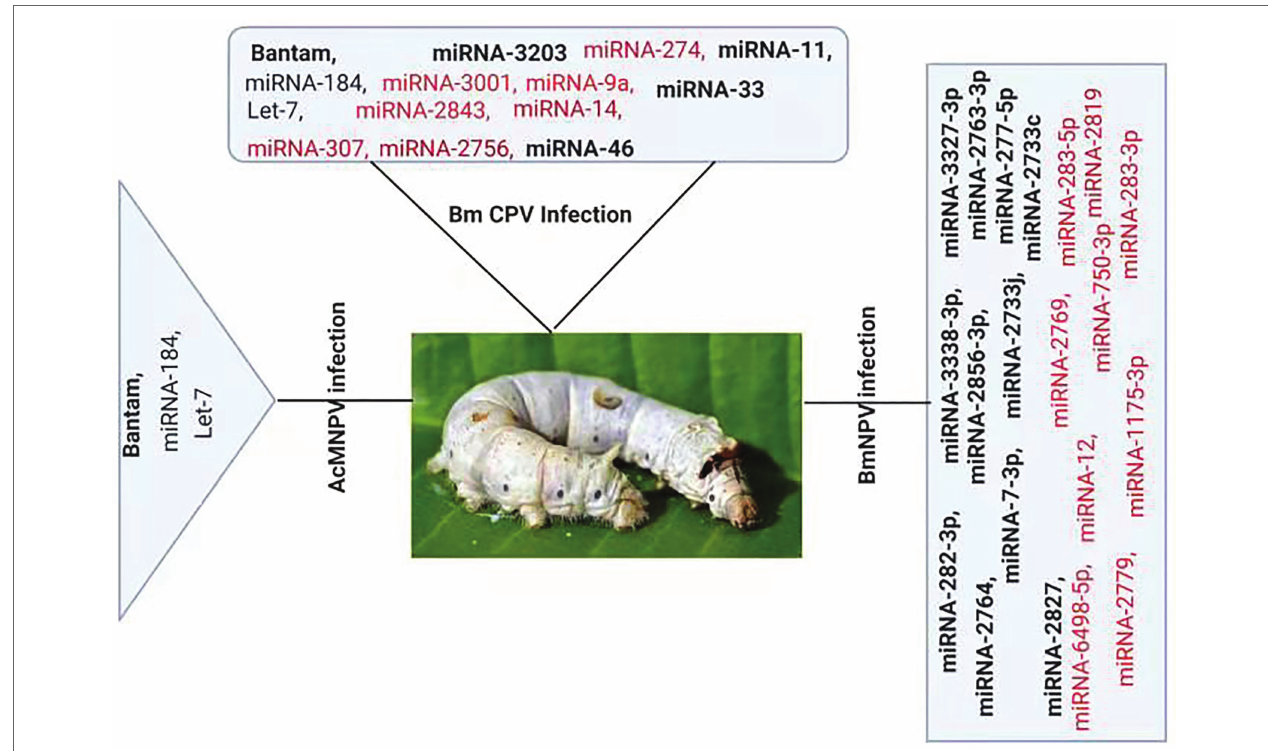
FIGURE 2 | Differential Expression of host miRNA upon viral invasion: Regulation of miRNAs upon BmNPV, BmCPV, and AcMNPV. Red color represents down- regulated, while bold black represents up-regulated miRNAs after the viral attack.